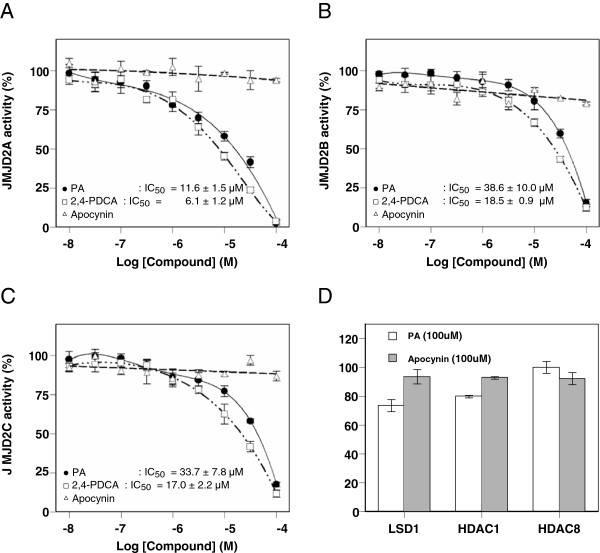
Effects of PA on the activities of histone demethylases. (A) Effects of PA, apocynin or 2,4-PDCA on histone demethylase JMJD2A activity. IC50 values are mean ± SEM of three separate experiments. (B) Effects of PA, apocynin or 2,4-PDCA on histone demethylase JMJD2B activity. IC50 values are mean ± SEM of three separate experiments. (C) Effects of PA, apocynin or 2,4-PDCA on histone demethylase JMJD2C activity. IC50 values are mean ± SEM of three separate experiments. (D) Effects of PA or apocynin on the activities of lysine-specific demethylase LSD1, histone deacetylase HDAC1 and HDAC8. Values are mean ± SEM (n = 4). Data are expressed as a percentage of the control value in each experiment.